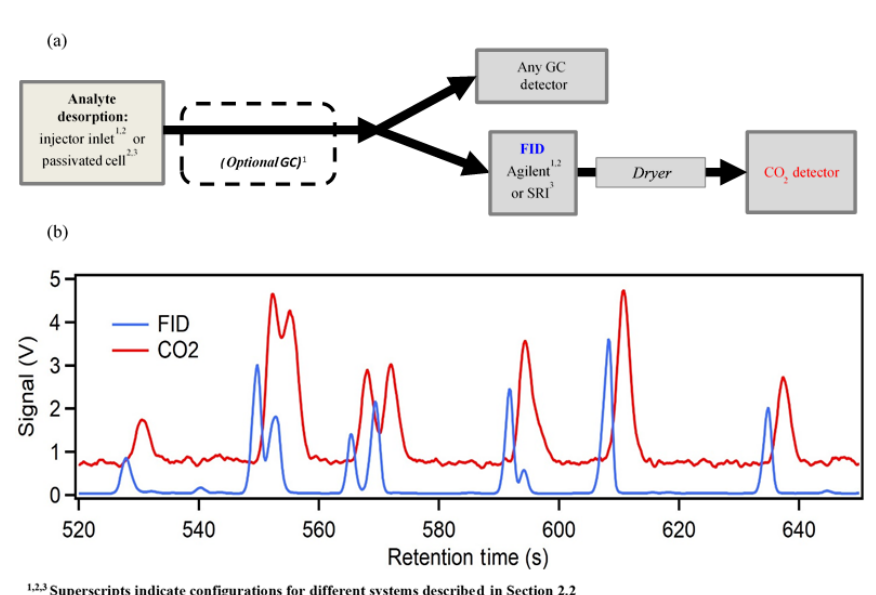
Figure 2. (a) A generalized schematic of the instrument configurations (b) . Sample data of simultaneously measured FID and CO 2 signals collected on System 1 (i.e., including optional